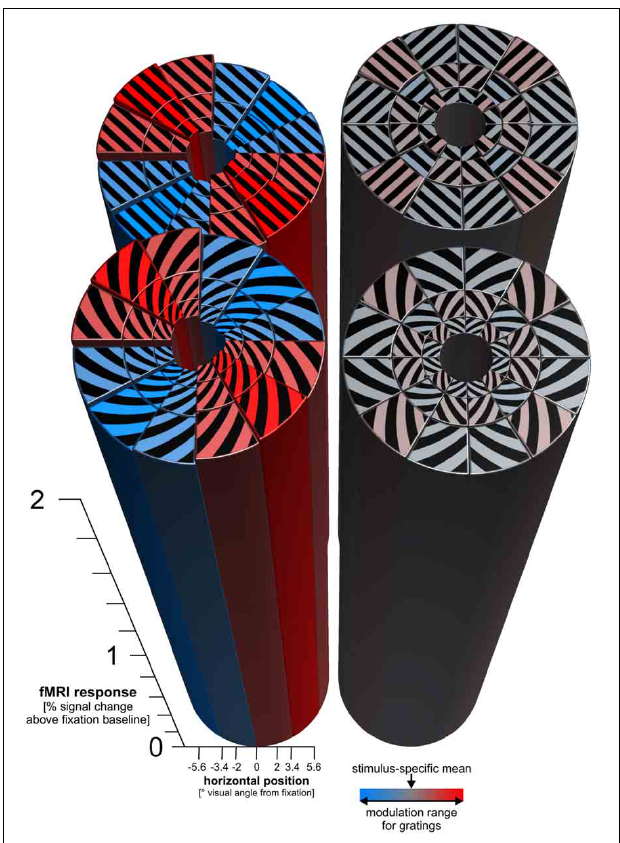
FIGURE 4 | Radial and vertical preference maps. The figure shows the response predictions of cosine-tuning models of radial and cardinal preference. For each log-polar patch of a stimulus, a bar shows the response of the V1 region representing that patch. Each patch responds strongly to each stimulus (overall height of the bars > 2% signal change). On top of the strong overall response, there is a subtle modulation consistent with a global radial preference for gratings ( ± 0.025% signal change). There is a similar subtle modulation consistent with a vertical preference map for spirals ( ± 0.021% signal change). For patch-swapped stimuli, these modulations were much smaller ( ± 0.0028% signal change for patch-swapped gratings, ± 0.0018% signal change for patch-swapped spirals). These effect sizes are amplitude parameter estimates of cosine-tuning models (see Methods), averaged across all 18 participants. For inference on these effects, see Figure 5 .